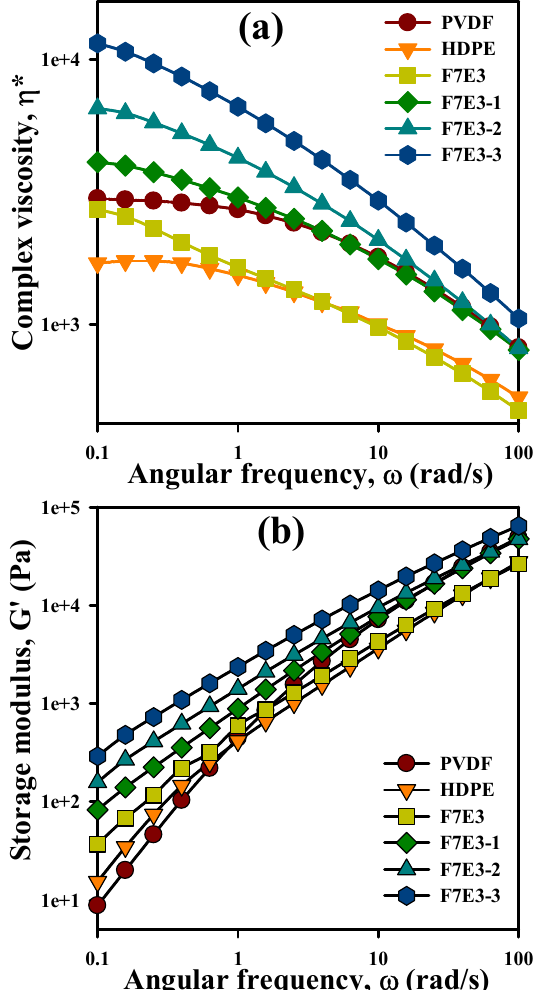
Figure 8. Rheological properties of the selected samples: ( a ) ղ * vs. 𝜔 and ( b ) G ′ vs. 𝜔 .